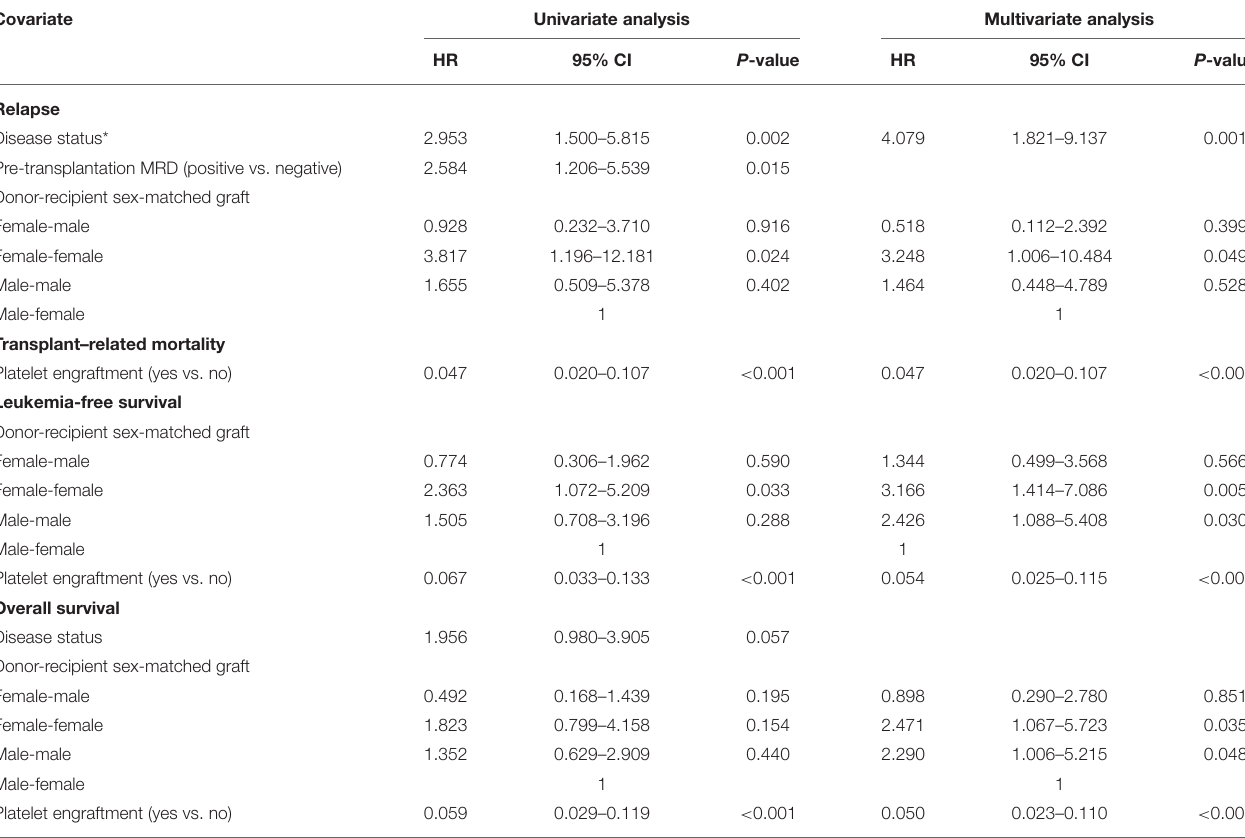
TABLE 2 | Multivariate analysis of factors associated with outcomes of patients with Ph positive ALL who underwent allo-SCT ( n = 202). Covariate Univariate analysis Multivariate analysis HR 95%